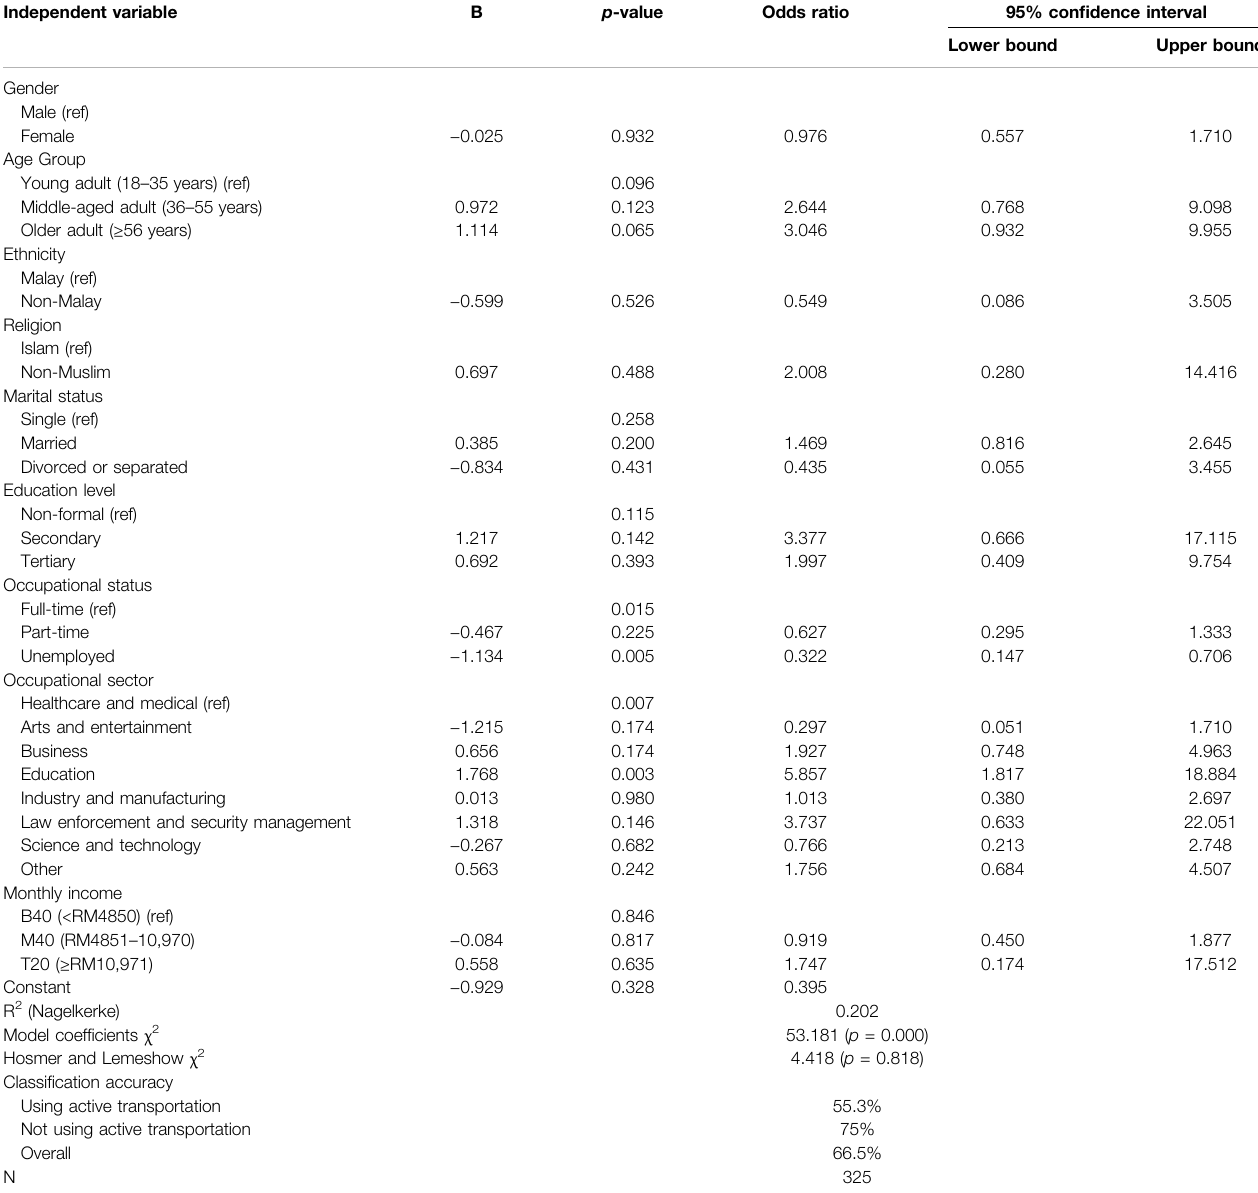
TABLE 6 | Logistic regression model of predictors of active transportation use. Independent